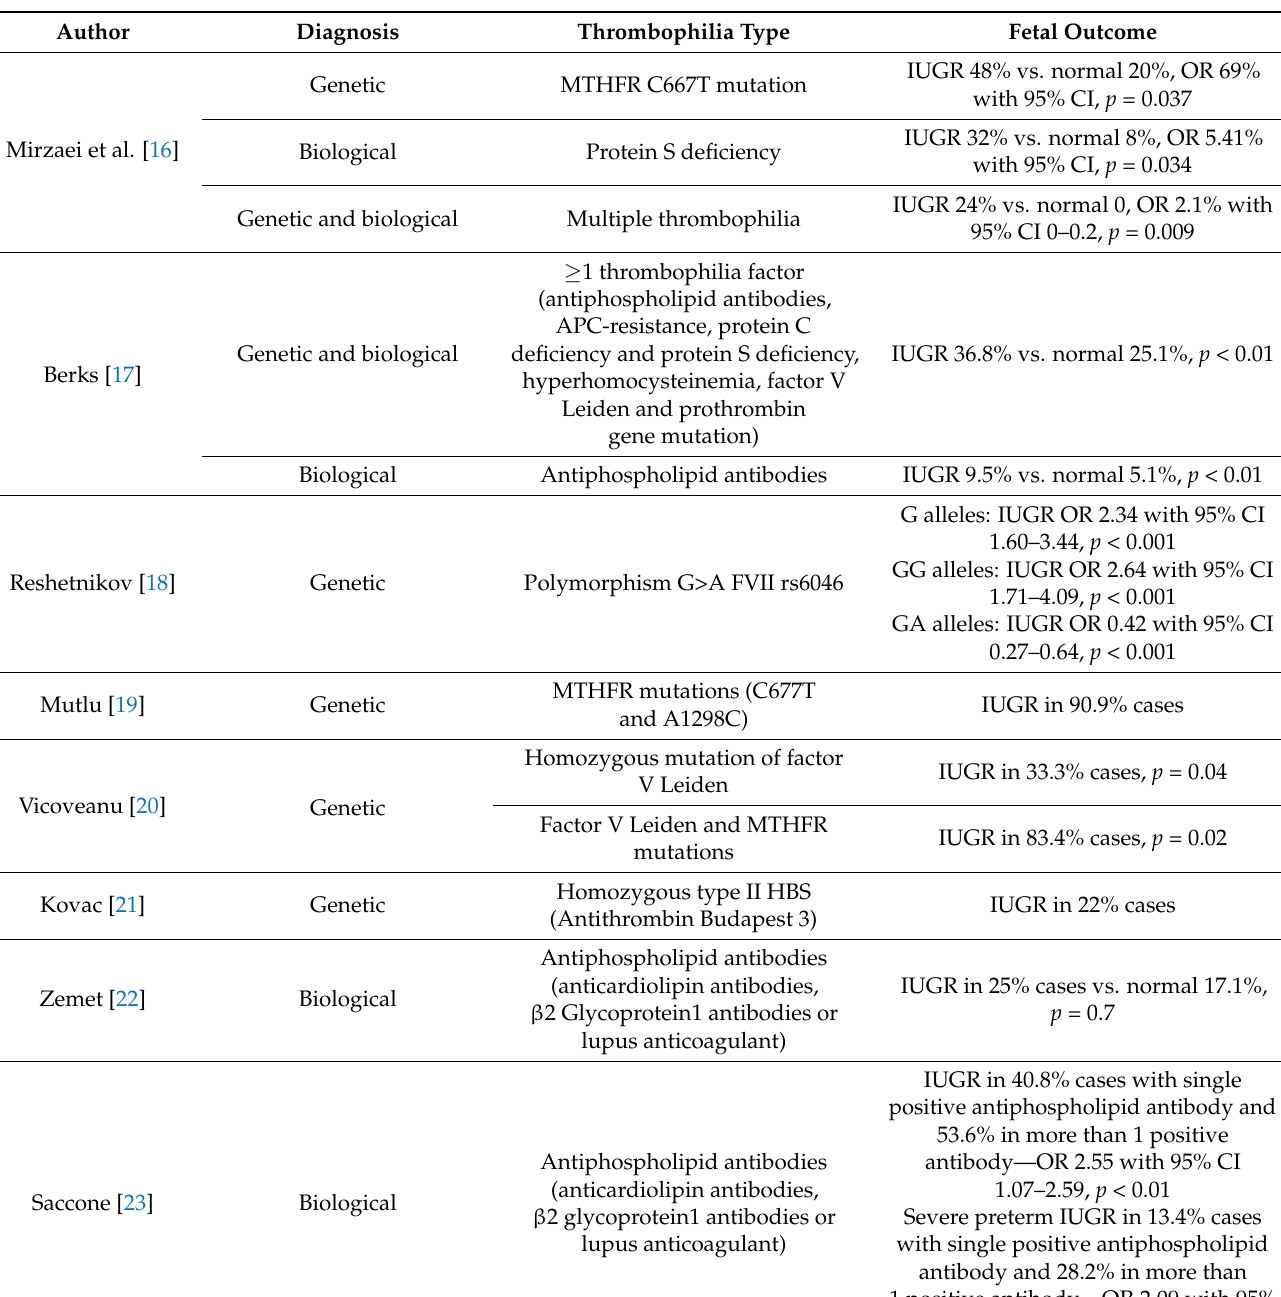
Table 1. Summary of the results: thrombophilia diagnosis and type and fetal outcome, especially intrauterine growth